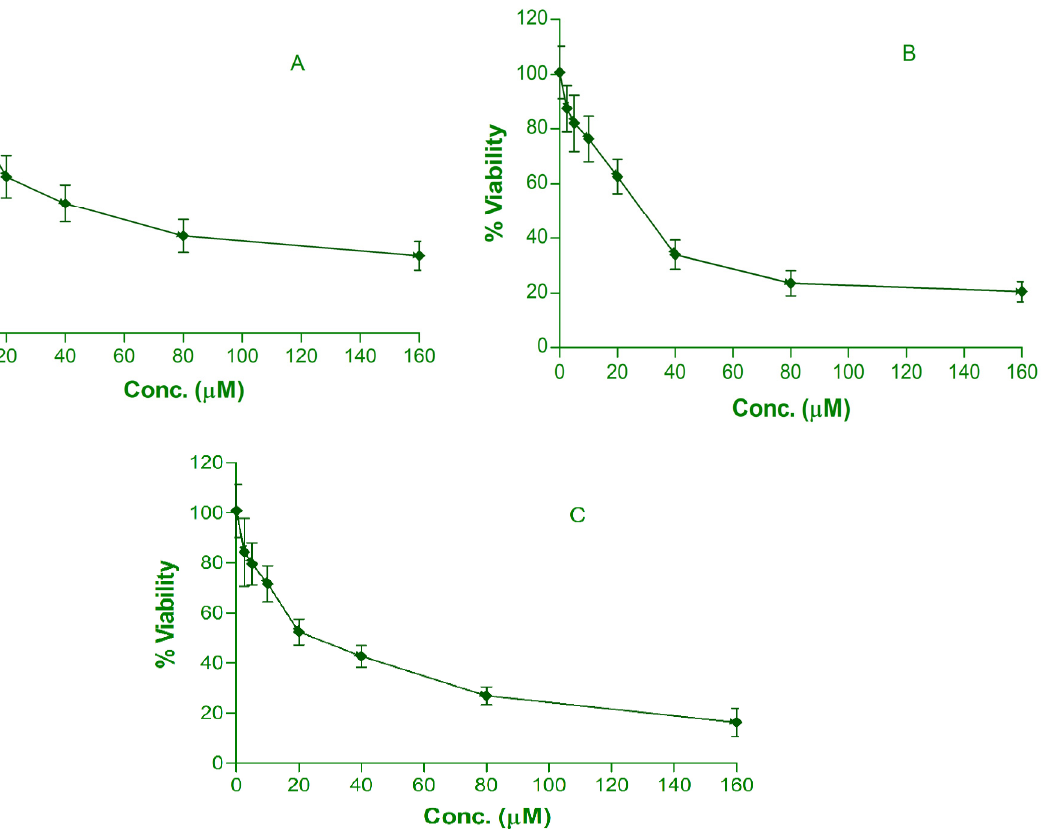
Figure 4. Viability (%) of QNE- ( A ), CNE- ( B ) and QC-NE ( C )-treated MCF-7 cells. IC 50 values for QNE-, CNE- and QC-NE-treated MCF-7 cells were identified to be 40.2 µ M, 28.12 µ M and 21.23 µ M, respectively.